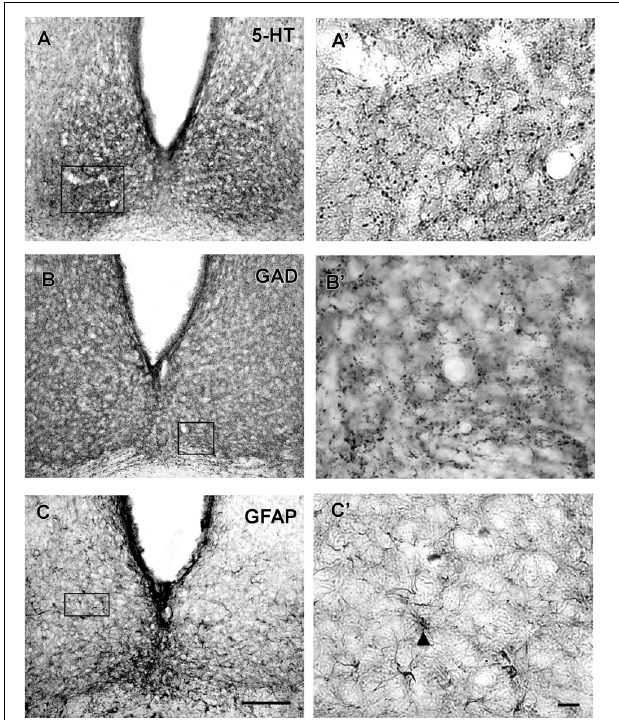
FIGURE 3 | Photomicrographs of SCN coronal sections showing the immunoreactivity pattern against VP at caudal level (A,A’) , VIP (B,B’), and NPY (C,C’) at the middle level. Black arrowheads point to spherical VP-IR and oval VIP-IR neurons. oc, optic chiasm; 3v, third ventricle; SCN, suprachiasmatic nucleus. Scale bar 100 µ m (A,B) and 10 µ m (A’,B’) .